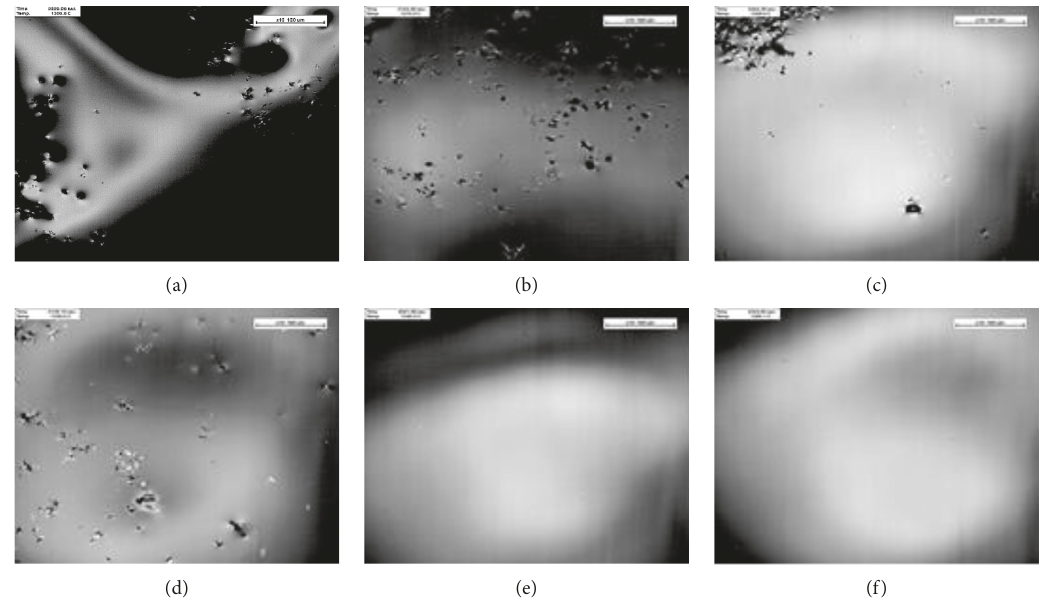
Figure 4: The evolution rules of morphology with 1% B